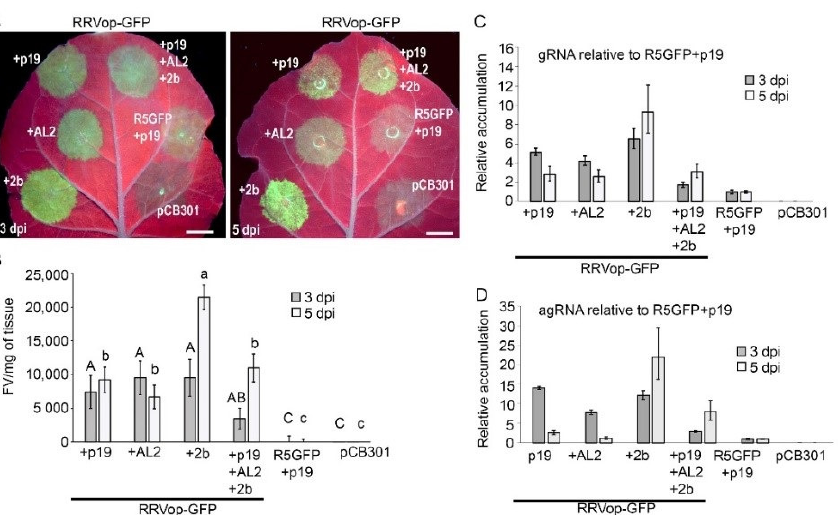
Figure 5. Co-delivery of three silencing suppressors with RRVop-GFP minireplicon. ( A ) Fluorescence images show the RRVop-GFP and silencing suppressors in N. benthami ana leaves at 3 and 5 dpi. Controls include the R5GFP +p19 only or the empty vector pCB301. Scale bars represent 1 cm. ( B ) The graph shows the average FV/mg- tissue and is representative of three experimental replicates ( n = 6). Lines through the bars represent standard error of the means. The transcription levels of g ( C ) and ag ( D ) GFP RNA were measured via RT-qPCR using the tagged RT primer strategy. The results are presented as relative to R5GFP +p19 using the double delta Ct method. Actin primers amplified the endogenous control. The error bars represent ranges calculated from the mean Ct with a 95% confidence interval. For (B, C, D) multiple comparisons of the means were performed using ANOVA and Tukey’s HSD ( p < 0.05). Lowercase letters indicate comparisons across 3 dpi and up- percase letters across 5 dpi. Values with the same lowercase or uppercase letter are not statistically different.